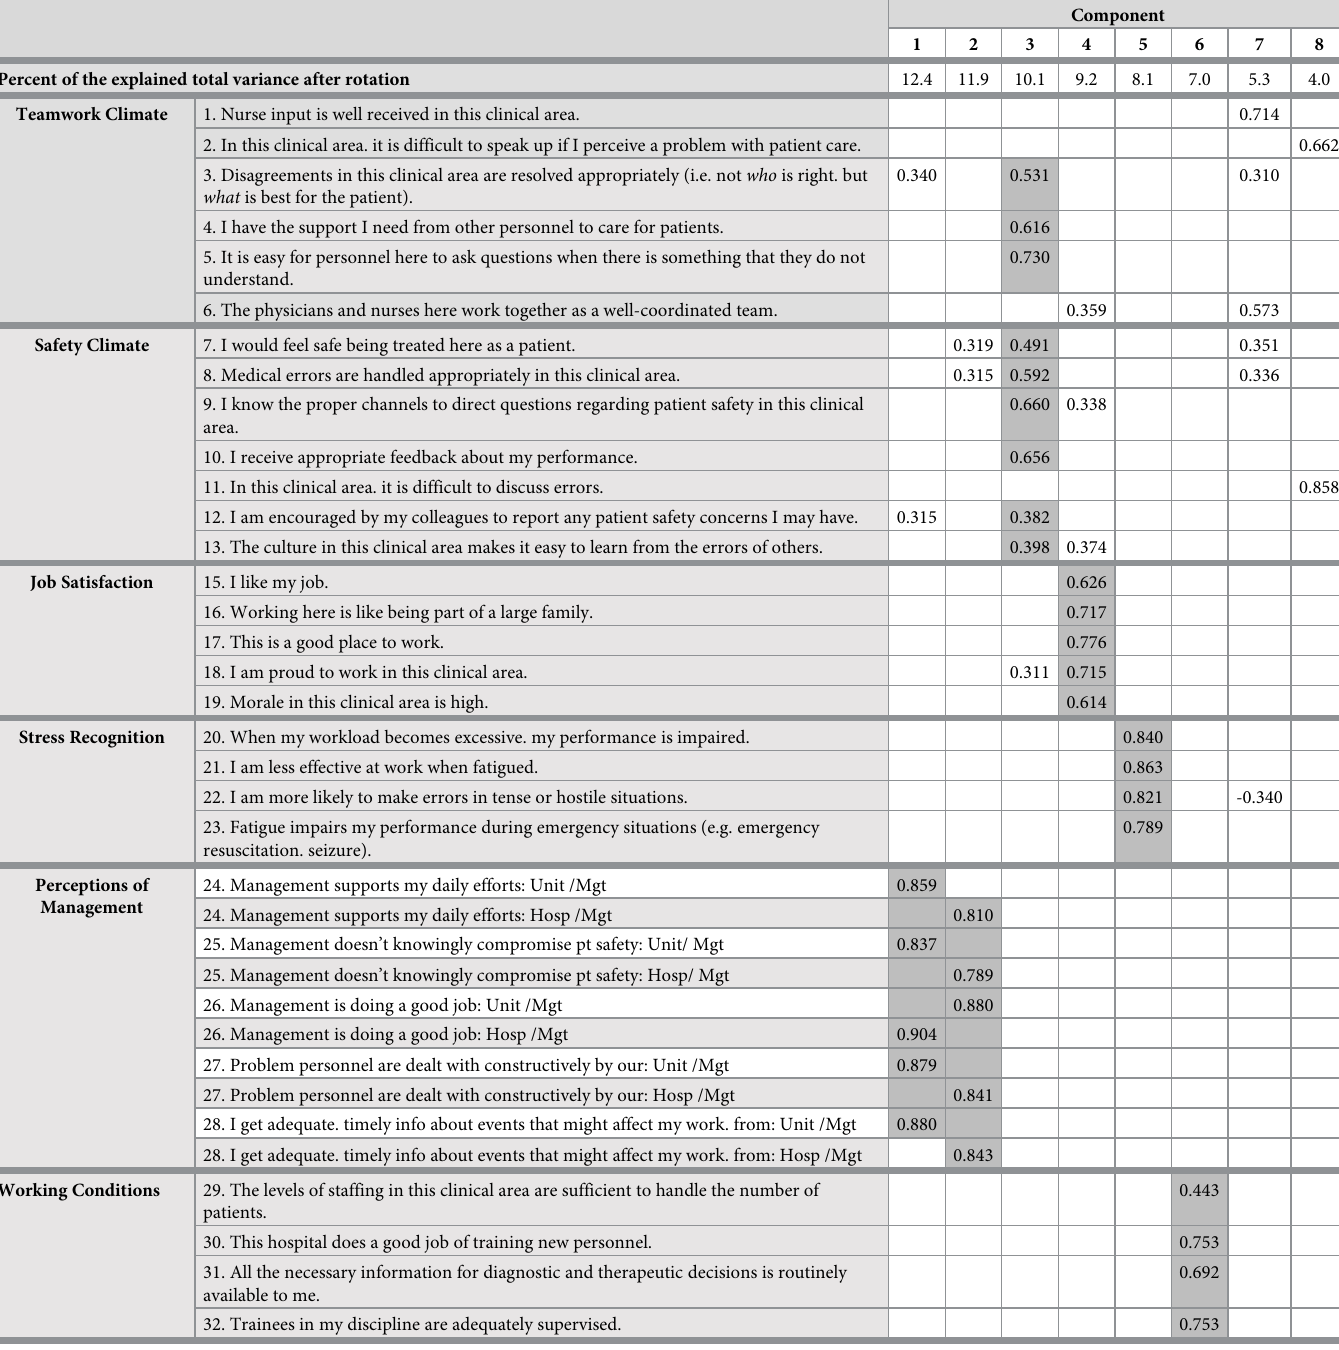
Table 3. The values of factor loadings of statements of the Polish version of SAQ-SF, obtained with exploratory factor analysis (N =